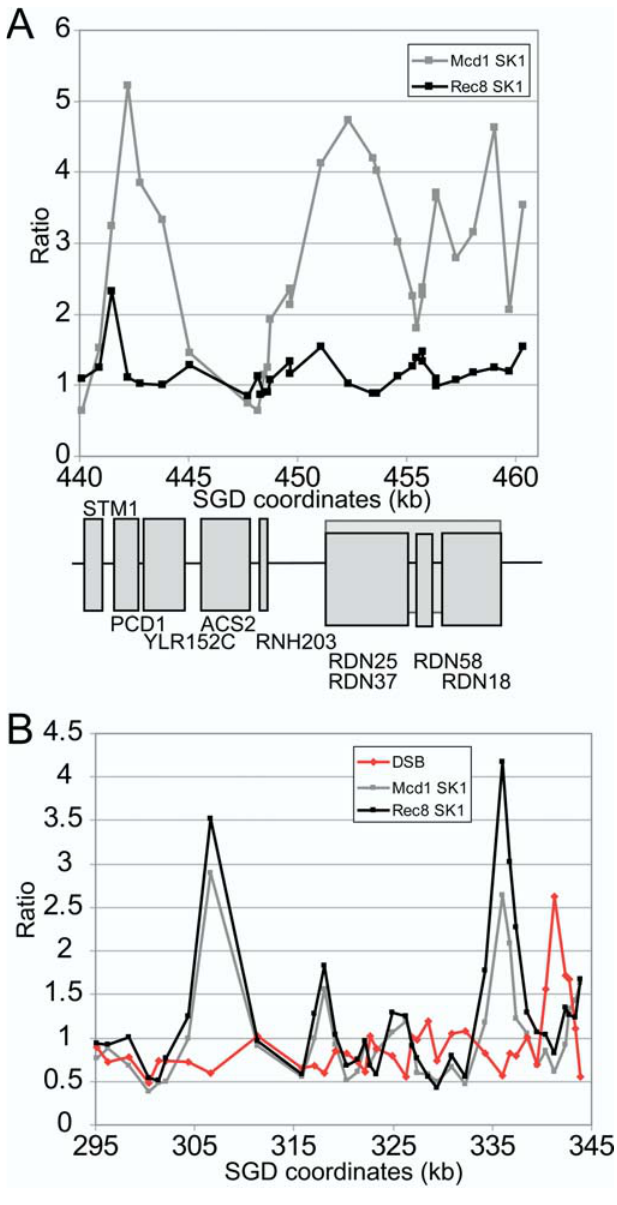
Figure 8. Meiotic Cohesin DSB data are shown in red, Rec8 data in black, and Mcd1 data in grey. (A) Ratios for meiotic cohesin are compared to mitotic cohesin in SK1 for kilobasepairs 440–461 on Chromosome XII. For the mitotic culture, cells were arrested with nocodazole. For meiotic cells, timepoints were collected every 2 h from hour 4 to hour 12 after transfer to SPM. The median ratio value was used to represent the data. Meiosis is slower in an SK1 strain with an HA-epitope-tagged Rec8 than in a wild-type strain (see Figure 9). The gene structure for this locus is shown below the graph, with genes encoded by the Watson strand labeled on top and genes encoded by the Crick strand labeled on the bottom. (B) Ratios for meiotic cohesin are compared to mitotic cohesin and DSBs for kilobasepairs 295–345 on Chromosome XII. DOI: 10.1371/journal.pbio.0020259.g008 The SC organizes meiotic chromosomes and aids interhomo- log recombination. In fact, meiotic cohesin has been shown to be required for meiotic recombination (Klein et al. 1999).